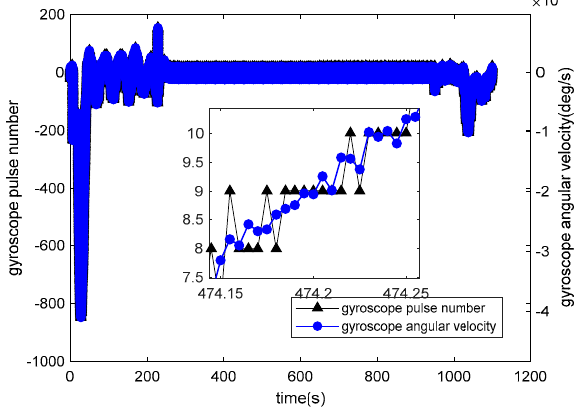
Figure 9. Output of accelerometer pulse number and accelerometer specific force.